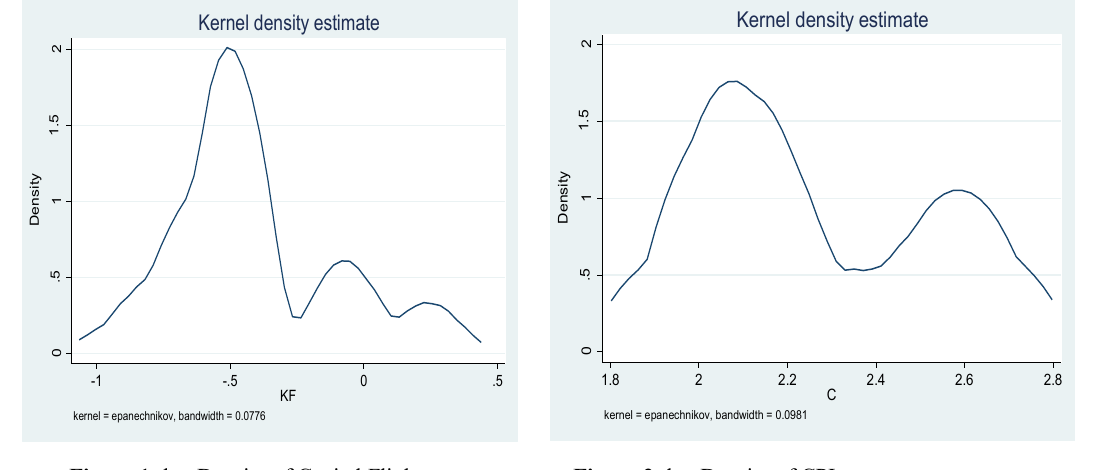
Figure 1: k – Density of Capital Flight Figure 2: k – Density of CPI